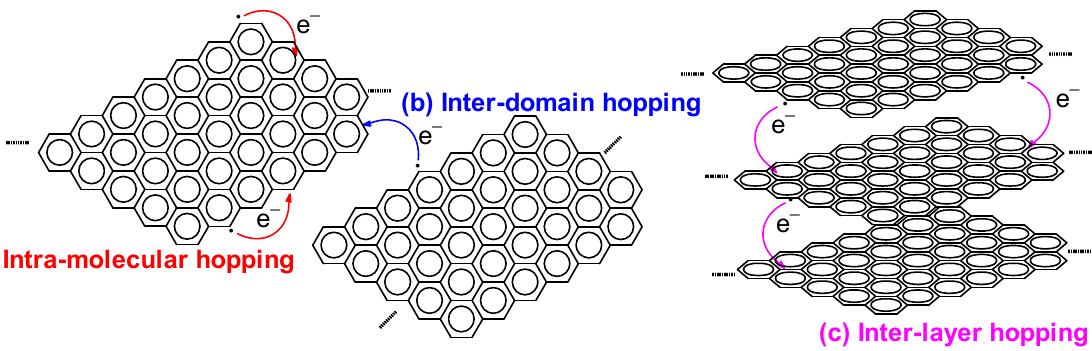
Figure 14. ( a ) Intra-molecular hopping; ( b ) Inter-domain hopping; ( c ) Inter-layer hopping in plausible structures.